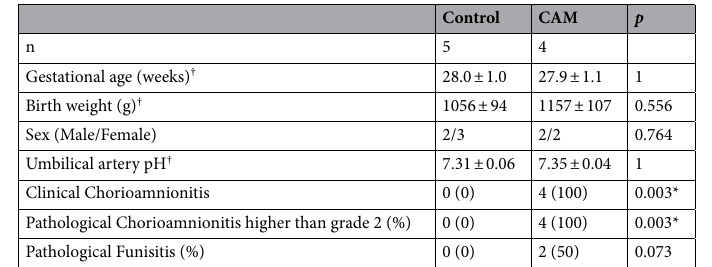
Table 1. Clinical backgrounds of the subjects. * p < 0.05, † average ±